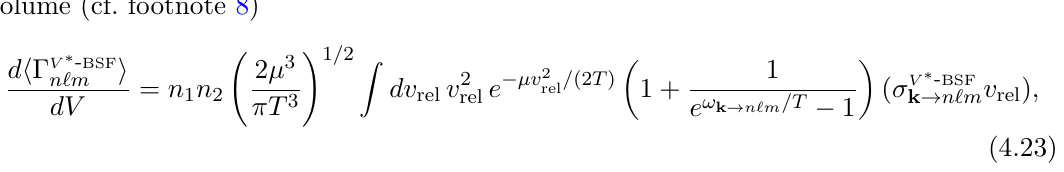
factors of eqs. (4.20) and (4.21) that determine the ratio of BSF Figure 13 . Left : the R ± and R H via off-shell H ( † ) scattering over on-shell H ( † ) emission. Right : the R that determine the ratio of BSF via off-shell B or W scattering on fermions over on-shell B or W emission. Also shown, the R factor from [58] (cf. footnote U (1)